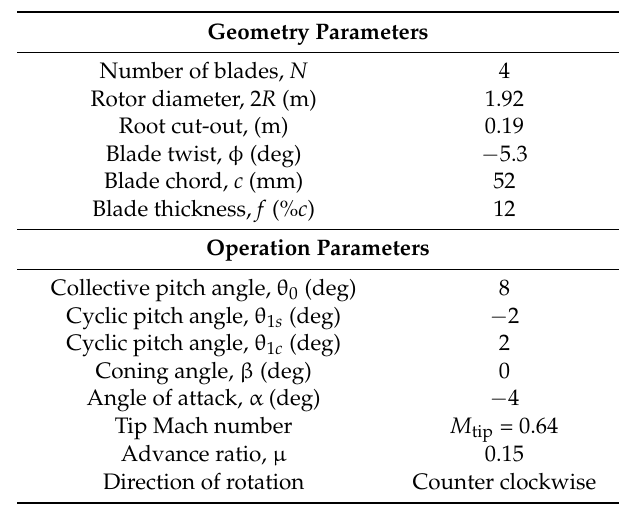
Table 1. Main rotor parameters.